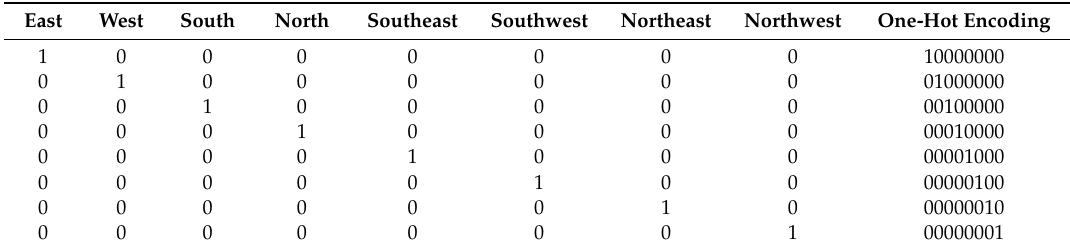
Table 3. The one-hot encoding of the wind